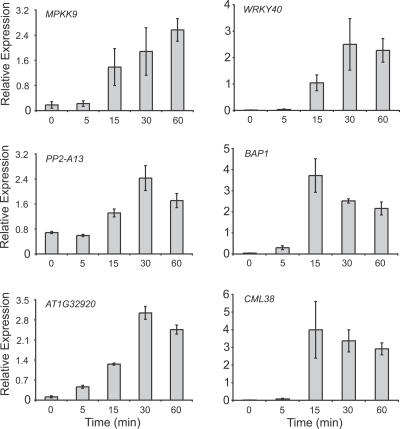
Selected RWR Genes Displaying a Rapid and Stable Expression Pattern Following Mechanical WoundingTotal RNA was extracted from 3-wk-old mechanically wounded tissue and subject to RT-qPCR analysis. AtMPKK9, WRKY40, AtPP2-A13, BAP1, AT1G32920, and CML38 transcripts were normalized to the 60S ribosomal protein L14 measured in the same samples. Data are means of n = 3 ± SEM.